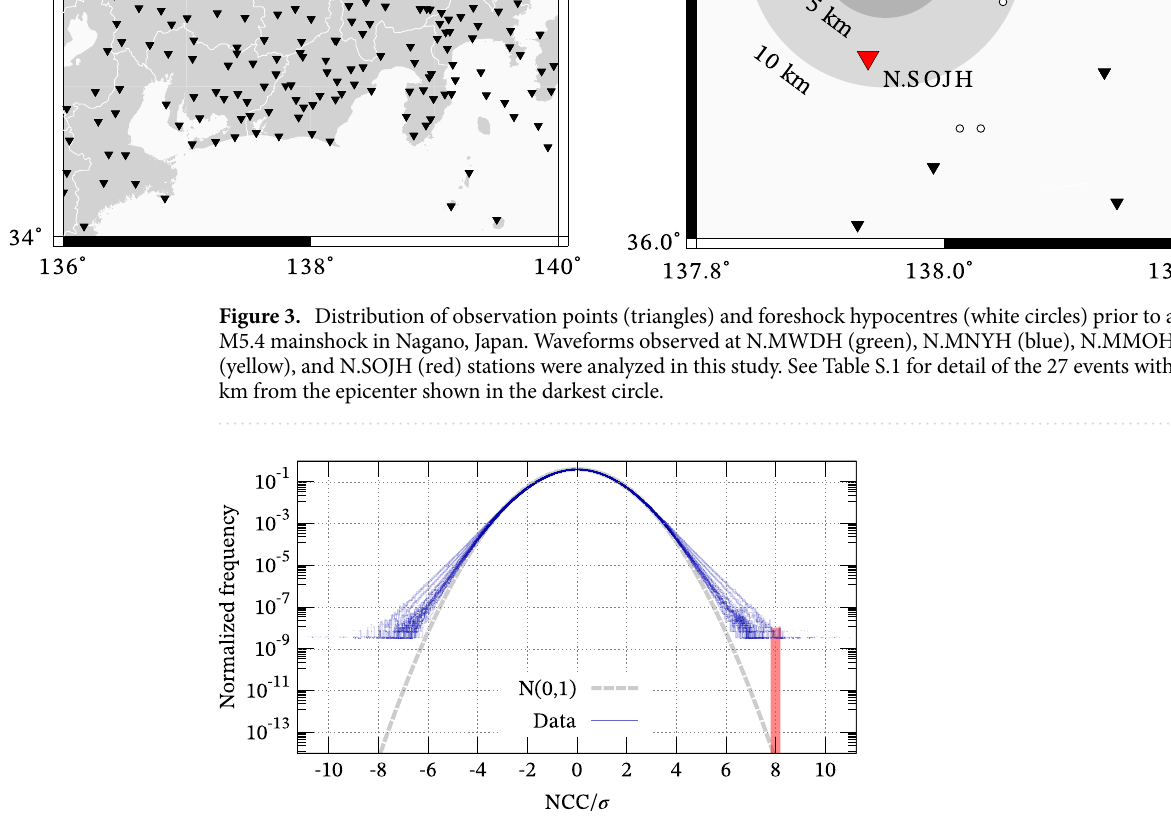
Figure 4. Empirical distribution of NCC between 2-year continuous records and 27 template waveforms (blue). The abscissa is normalized by the standard deviation. The vertical red bar indicates that the empirical distribution is several orders larger than the normal distribution (gray) at 8 σ